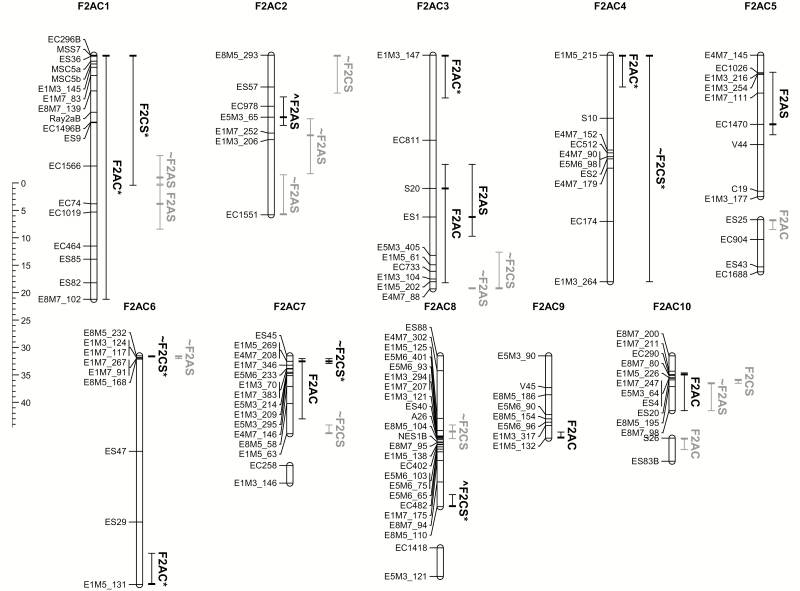
Genetic map locations and evidence for co-location of F2AS and F2CS transmission distortion loci transposed onto the F2AC genetic map. The F2AC genetic map was used as a reference against which to compare TRDL locations. Genetic map features are as described in the notes to Fig. 1. TRDL locations are represented as vertical lines to the right of F2AC LGs and named after the genetic map in which they were observed. The lines depicting TRDLs extend to cover linked genetic markers showing TRD. A bold cross hatch indicates the location of the marker with greatest TRD within that TRDL. Black lines indicate TRDLs identified from significantly biased genotype frequencies while grey lines indicate TRDLs identified by other tests (see Table 2). * after TRDL names indicates that χ2 test resulted in P < 0.0005. ~ before TRDL names indicates that the marker with greatest TRD was not found on the F2AC map but the approximate position and extent of the TRDL was estimated from synteny across genetic maps. ^ before TRDL names indicates that the marker with greatest TRD was present on a different LG compared to its F2AC location (see Table 2).